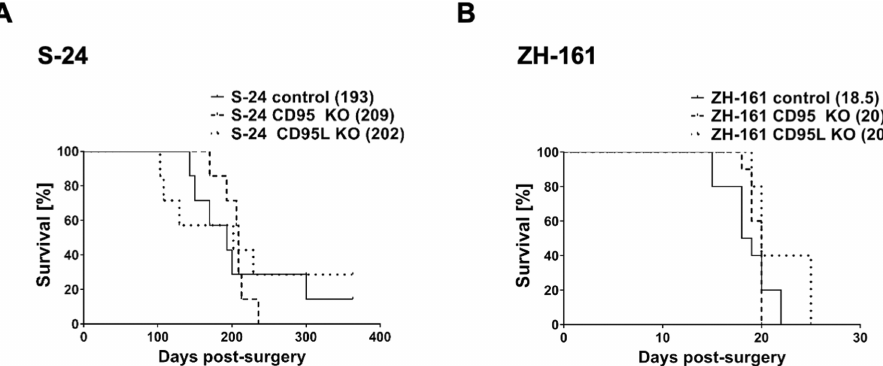
Fig. 5 Effect of CD95 or CD95L knockout (KO) in human GIC xenograft models. Crl:CD1- Foxn1 nu or Rj:NMRI- Foxn1 nu nude mice were intracranially implanted with control, CD95 KO or CD95L KO S-24 ( A ) or ZH-161 ( B ) cells. The control group includes mice implanted with naïve or CRISPR control cells, the CD95 KO group includes mice implanted with two different CD95 KO clones and the CD95L KO group includes mice implanted with two different CD95L KO clones. End-stage survival of n = 7 mice per group was recorded. Median survival in days is depicted, in brackets, next to the respective experimental group. The survival of control and CD95 KO or CD95L KO glioma-bearing mice was compared by means of a log-rank test. Statistical signi fi cance was not